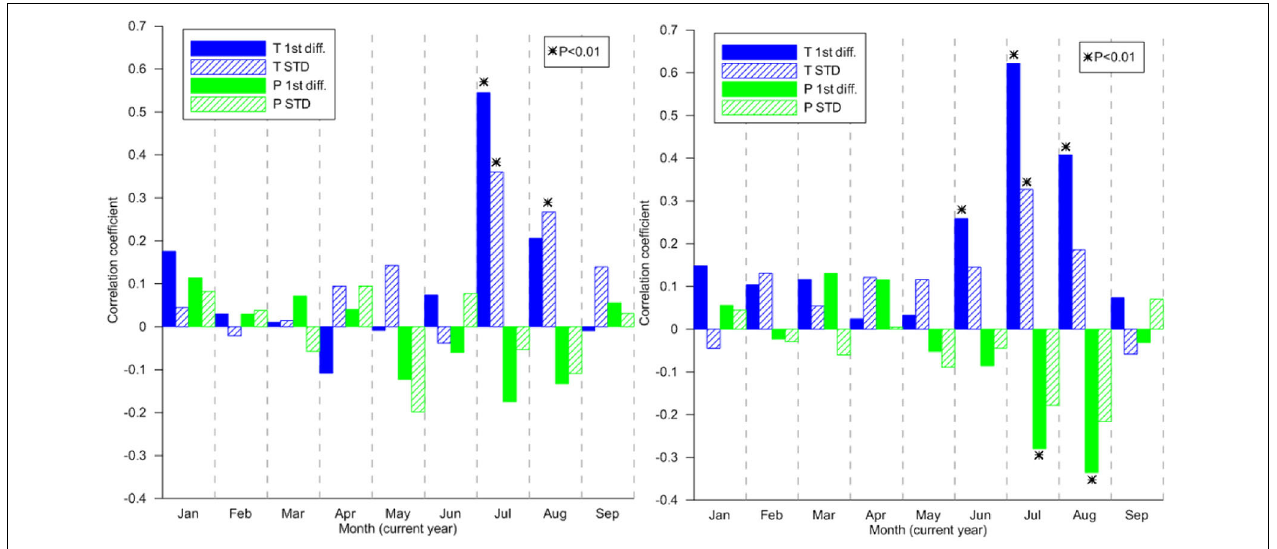
FIGURE 7 | Pearson correlation coefficients between 1st differenced (solid bar)/standardized (shaded bar) ring-width indices from (left) tree-line living tree chronology (Håckervalen 20 trees), (right) lake-shore